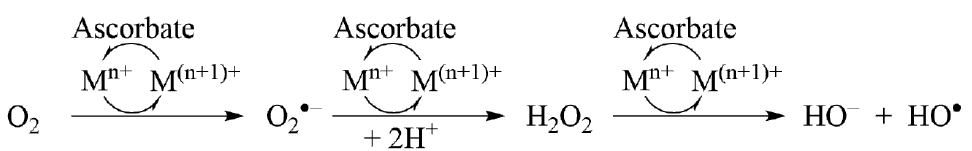
Figure 1. Metal-catalysed generation of reactive oxygen species (M n + : Cu(I) or Fe(II)).